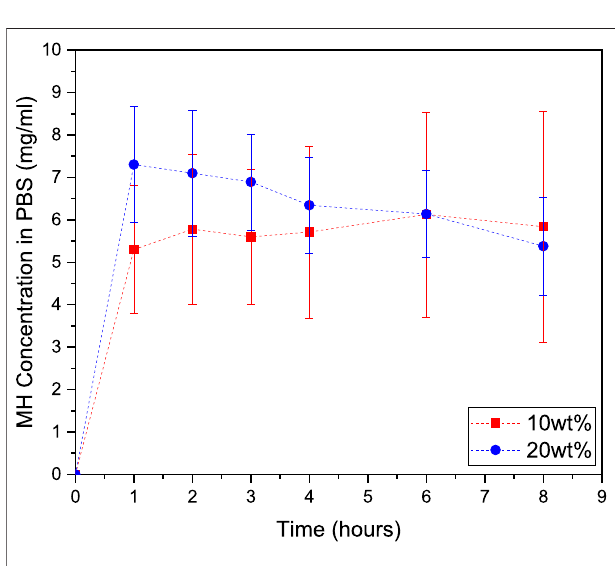
FIGURE 7 | Concentration of MH in solution after incubation of the coated scaffolds in PBS at 37 ° C.